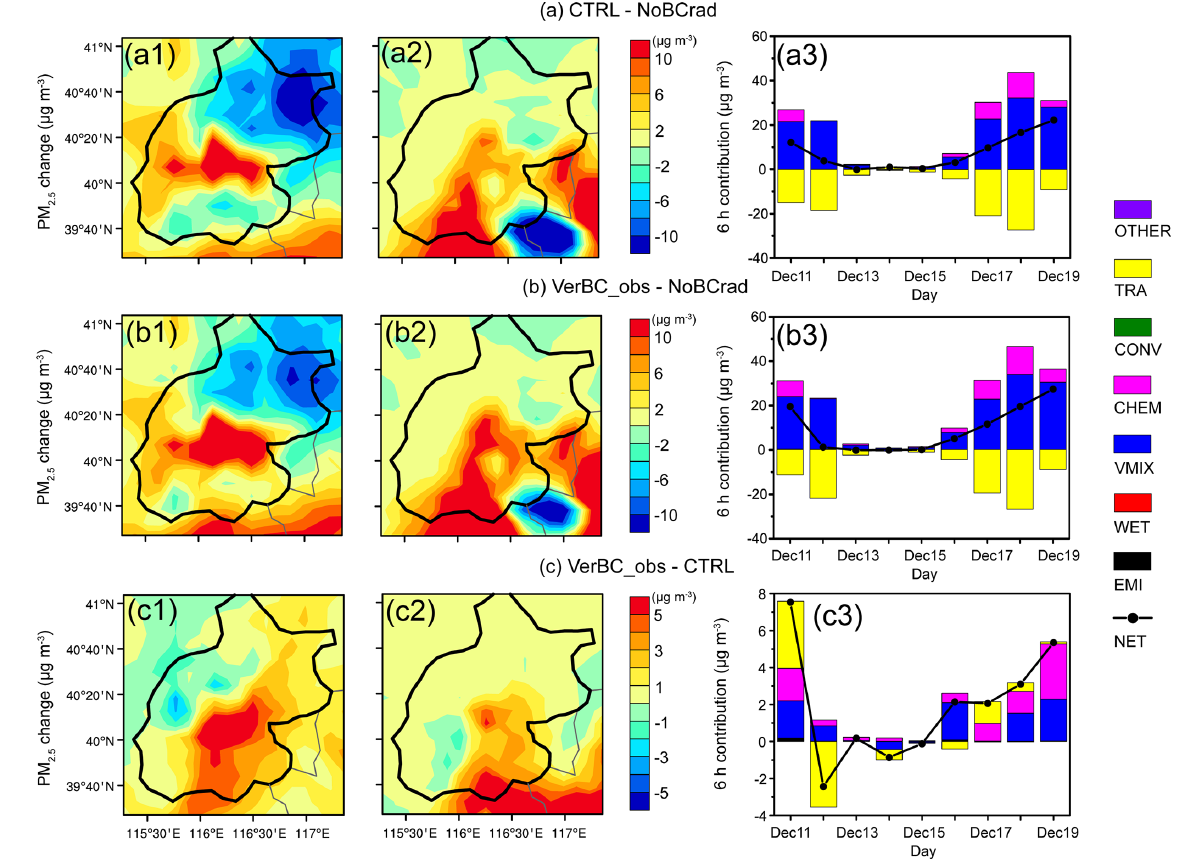
Figure 9. The spatial distribution of changes in near-surface PM 2 . 5 concentrations induced by BC DRE with the original (CTRL minus NoBCrad; a1, a2 ) and modified vertical profiles (VerBC_obs minus NoBCrad; b1, b2 ) and the difference between VerBC_obs and CTRL (VerBC_obs minus CTRL; c1, c2 ) over Beijing averaged over the period of 12:00–18:00LT of the two haze events. Panels (a1) – (c1) represent the first pollution event of 11–12 December 2016, and (a2) – (c2) represent the second pollution event of 16–19 December 2016. (a3–c3) The daily 6h contributions of each physical and chemical process (coloured bars, each of which is calculated as the concentration at 18:00LT minus that at 12:00LT) to the change in PM 2 . 5 in Beijing from 11 to 19 December 2016. The black dotted line represents the 6h net contribution to PM 2 . 5 change by summing over all